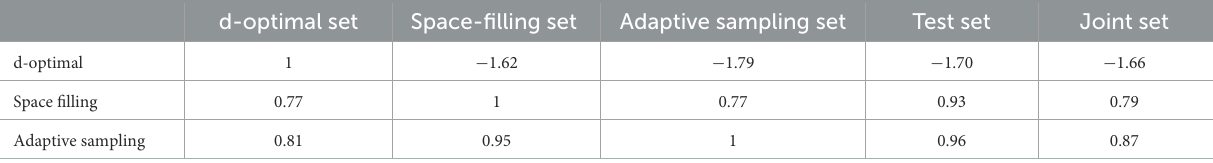
TABLE 6 Chest deflection R2 score of the trained models on the available